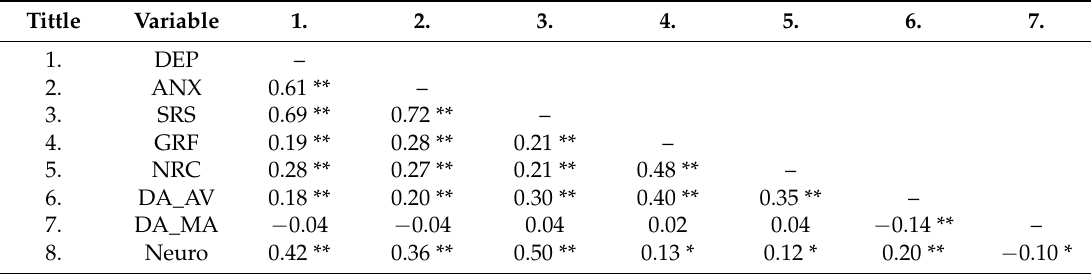
Table 1. Zero order correlations for predictor